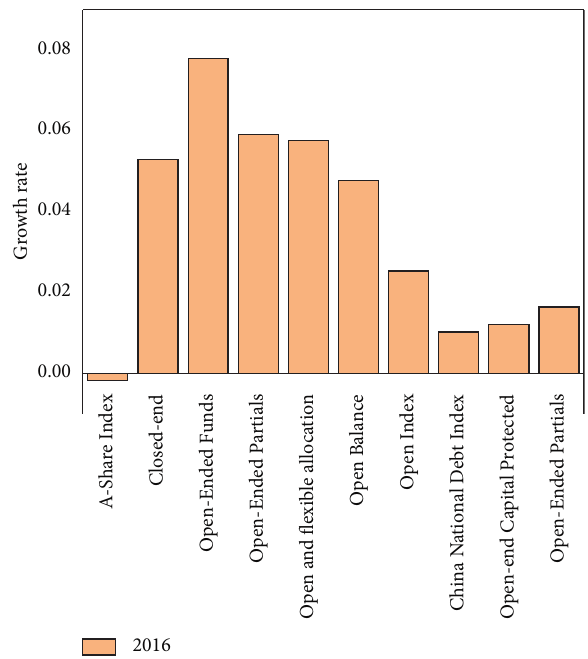
Figure 3: Fund growth